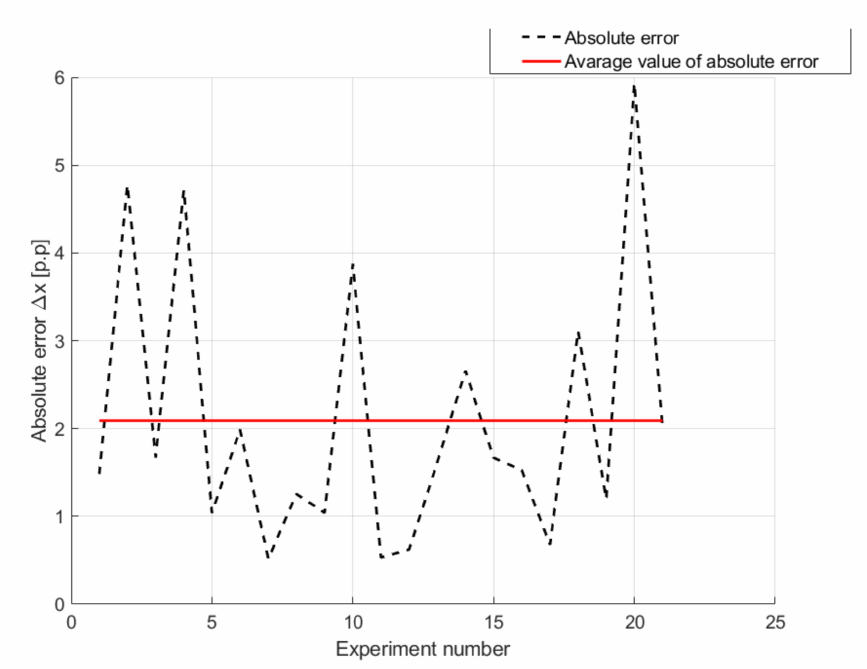
Figure 16. Absolute